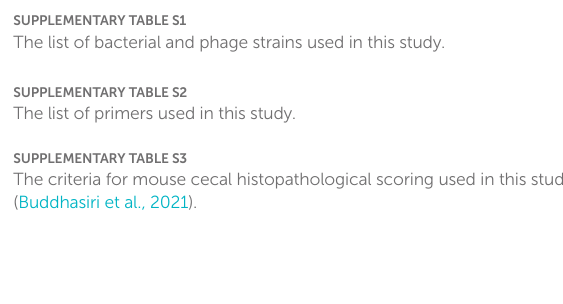
SUPPLEMENTARY FIGURE S1 The schematic of phage treatment in S. Typhimurium-infected mouse model established in this study. After one-week acclimatization, 6–8 week- old female C57BL/6NJcl mice were orally fed with 100 μ l of 200 mg/ml streptomycin sulfate 1 day before S. Typhimurium oral infection with 100 μ l of 10 9 CFU/ml (10 8 CFU/mouse). Infected mice were divided into 4 groups (7 mice per group) and orally fed 100 μ l of 10 11 PFU/mL (10 10 PFU/mouse) of ST-W77, SE-W109, ST-W77 combined with SE-W109, and SM buffer as the indicated time point. All mice were euthanized on day 4 post-infection.